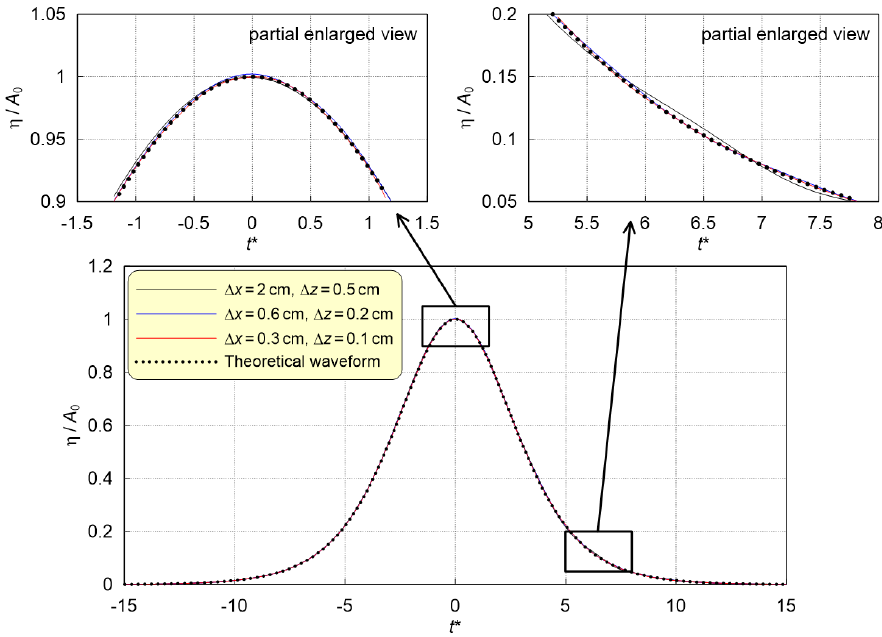
Figure 9. Comparison of incident waveform with the theoretical results for three grid